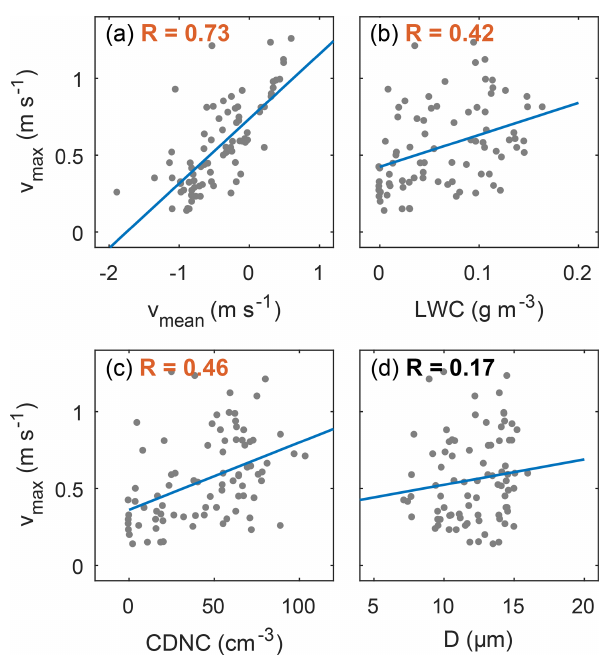
Figure 13. Correlations among dynamical ( v mean , v max ) and mi- crophysical parameters (LWC, CDNC, D ) of the low-level cloud properties. The dynamical properties that were observed with the cloud radar were averaged between the surface and 1850m. The gray dots represent the 2min averages for the time periods be- tween 16:20–17:55 and 18:30–19:45UTC. The blue lines indicate the least-square-regression line. The Spearman’s rank correlation coefficients are shown in the top left corner, where correlation co- efficients highlighted in orange indicate correlations significantly different from zero (5% significance